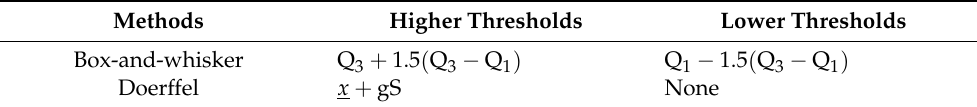
Table 1. Outlier identification thresholds for a sample using the box-and-whisker plot and Doerf- fel methods.